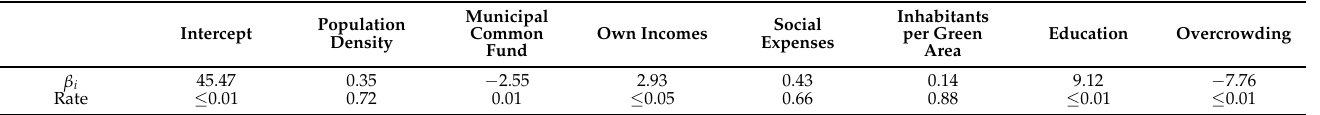
Table 11. Parameter estimation in efficiency model.